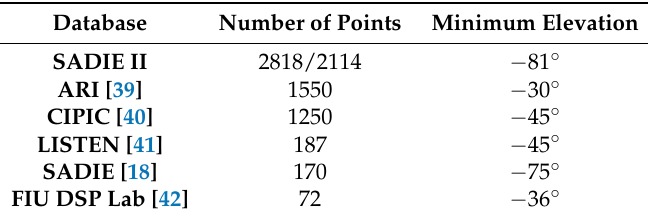
Table 2. A comparison of the number of points and minimum elevations measured by a number of popular human HRTF